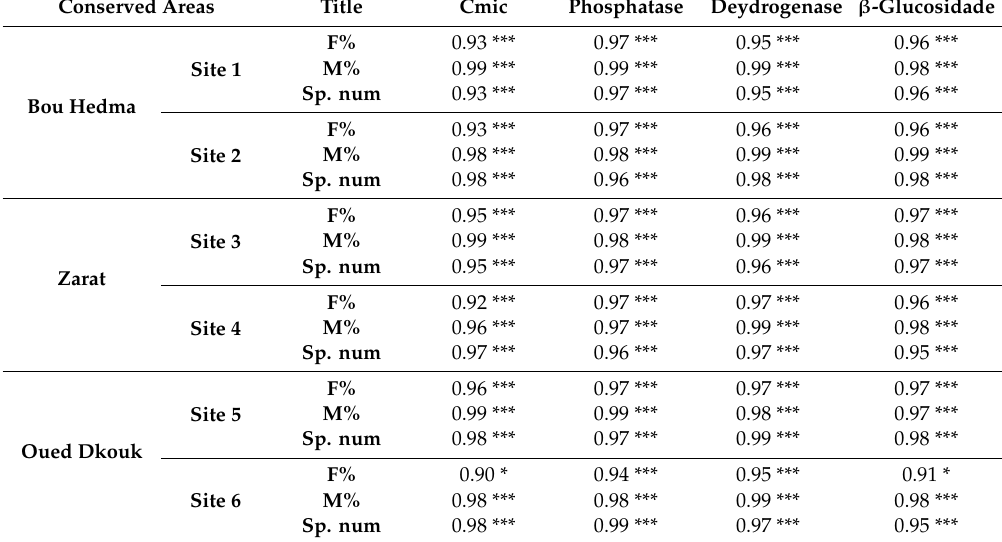
Table 4. Pearson correlation coe ffi cient between frequency of mycorrhization (F%), intensity of mycorrhization (M%) and density of AMF spores (Sp. num) and microbial activity expressed by microbial biomass (Cmic), phosphatase activity, dehydrogenase activity, and β -glucosidase activity. Conserved areas Title Conserved Areas Title Cmic